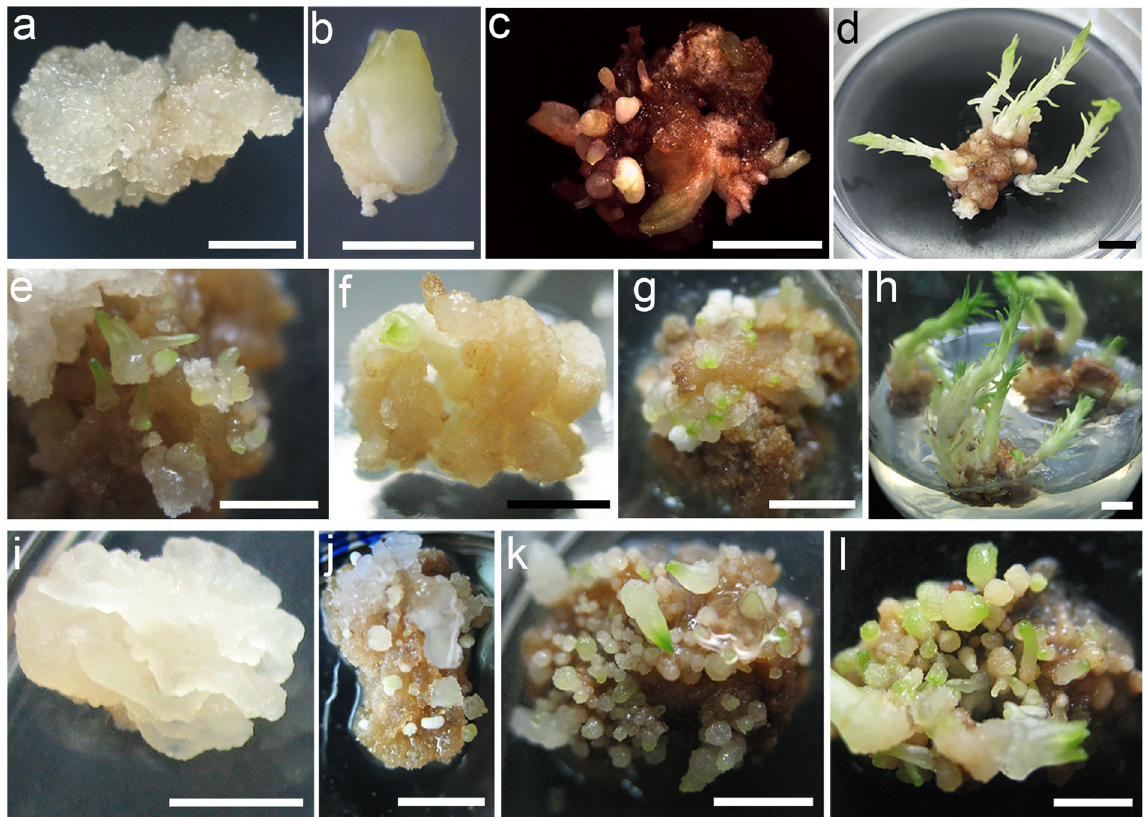
Figure 6. Effect of different plant growth regulators combination on somatic embryogenesis. ( a ) Callus induced by somatic embryo induction medium SEI1. ( b ) Swollen embryos in somatic embryo induction medium SEI2. ( c ) Cup-shaped or somewhat curved-shaped initial buds emerged from the surface of swollen embryos in medium SEI2. ( d ) Elongating adventitious buds in subsequent cultures. ( e ) White cap-shaped or columnar pro-embryos arose from a disaggregated watery callus in SEI1 medium. ( f ) Partly dedifferentiated callus. ( g,h ) Growing adventitious buds from a partly dedifferentiated callus in medium SEI2. ( i ) Completely dedifferentiated callus characterized by white translucent gullies and bulges attached to the surface. ( j–l ) White cap-shaped or columnar pro-embryos arose from a disaggregated watery callus in SEI2 medium. Hundreds of pro-embryos were observed during further proliferation and laurel-green cotyledons appeared from the embryonal head. Bars 5